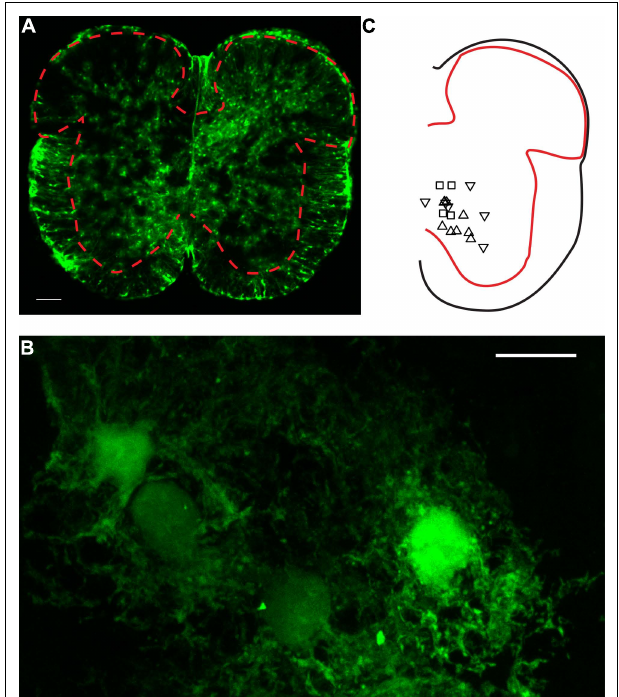
FIGURE 1 | Confocal microscopy of GFAP-EGFP astrocytes in spinal cord slices. (A) Image of a lumbar spinal cord slice from a neonatal mouse (P7) scanned with confocal microscopy.The red dashed line indicates the limits between gray and white matter. Note the presence of multiple protoplasmic fluorescent astrocytes in the gray matter. Scale bar: 100 μ m. (B) High magnification picture ( × 63) of ventral horn E-GFP positive astrocytes.Twenty-four consecutives parallel confocal plans were superimposed. Scale bar: 10 μ m. (C) Relative positions of a fraction of the neurons recorded for the study. Upward triangles indicate responses paired pulse stimulation protocol with a PPR > 1. Downward triangles correspond to a PPR < 1. Squares: PPR ≈